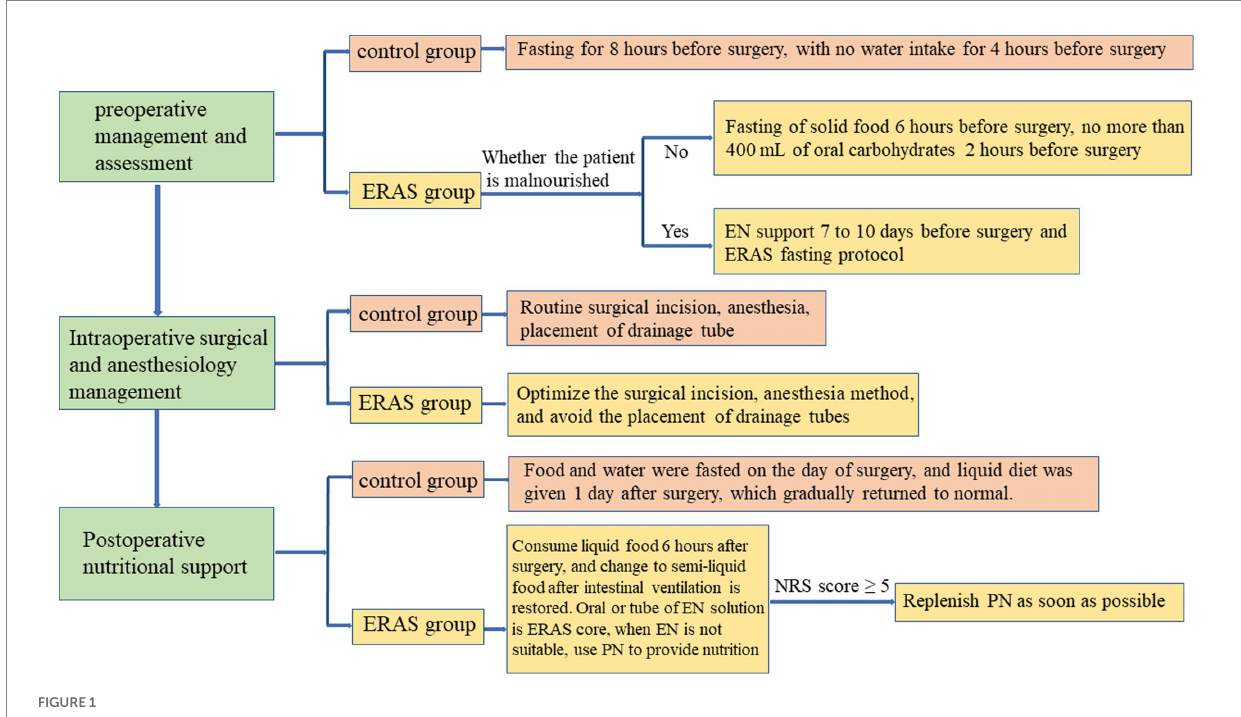
FIGURE 1 Summary of nutritional interventions in the two